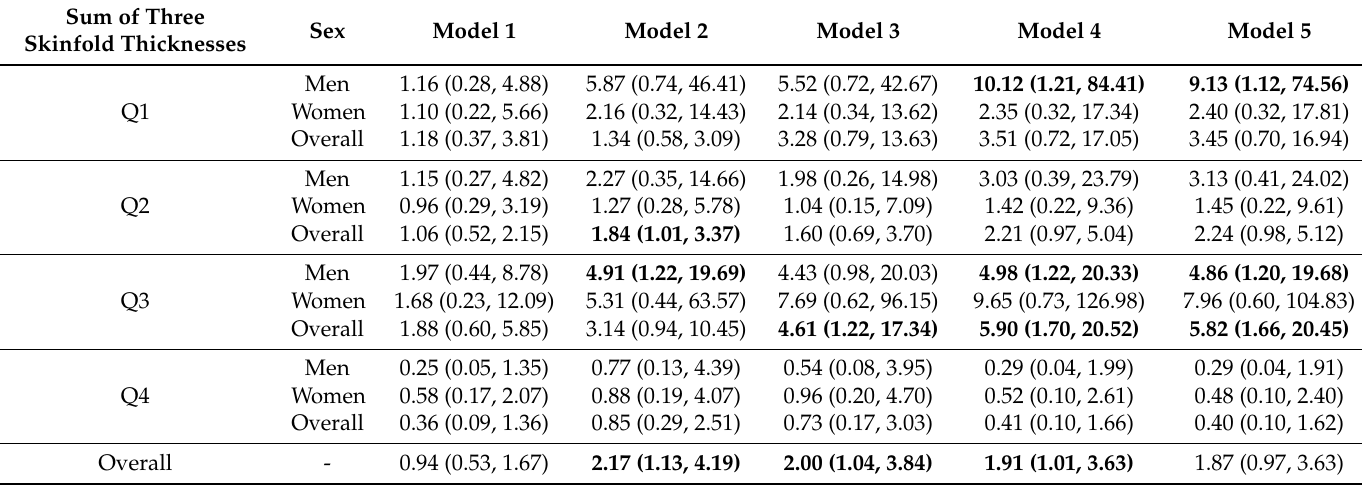
Table A1. Odds ratios for skipping breakfast by a one-unit increment in log-transformed leptin level (base 10), stratified by the sum of subcutaneous fat thickness, the National Health and Nutrition Examination Survey (NHANES) III,